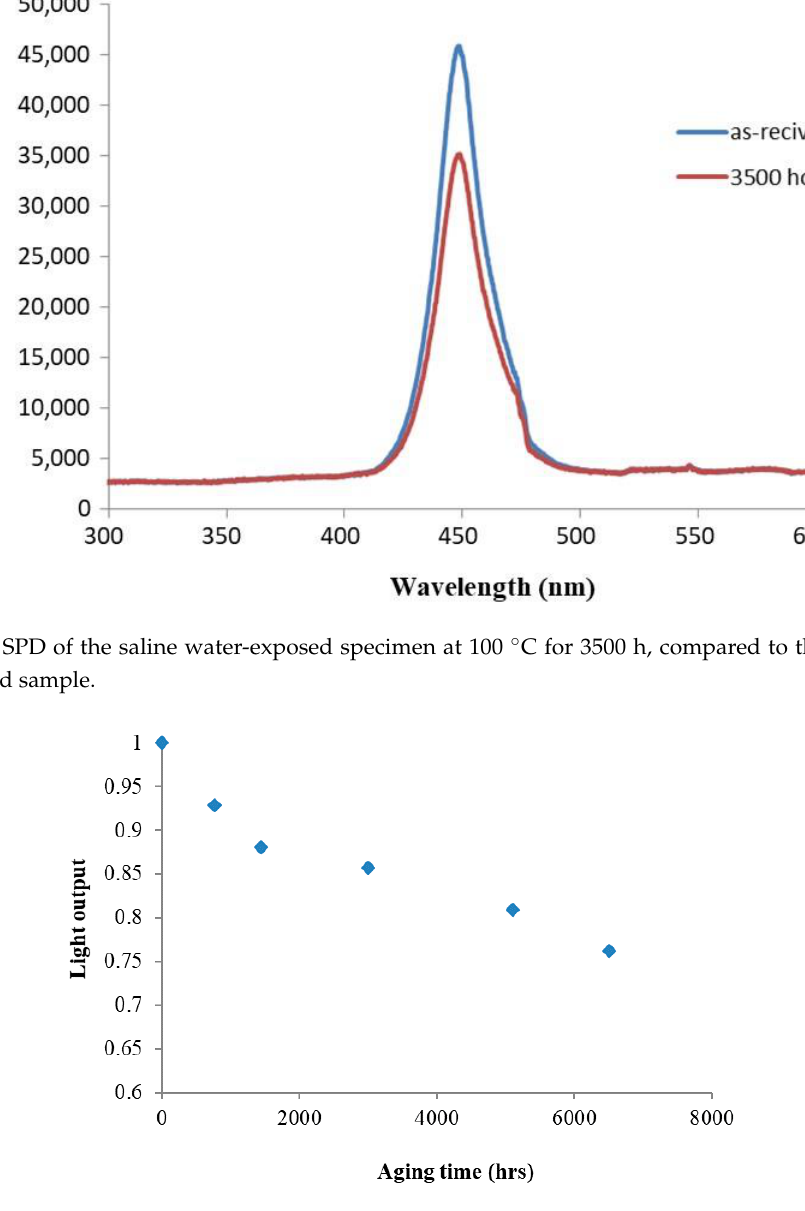
Figure 7. Variation of maximum power intensity at 450 nm with exposure time under a saline water environment condition at 100 °C.